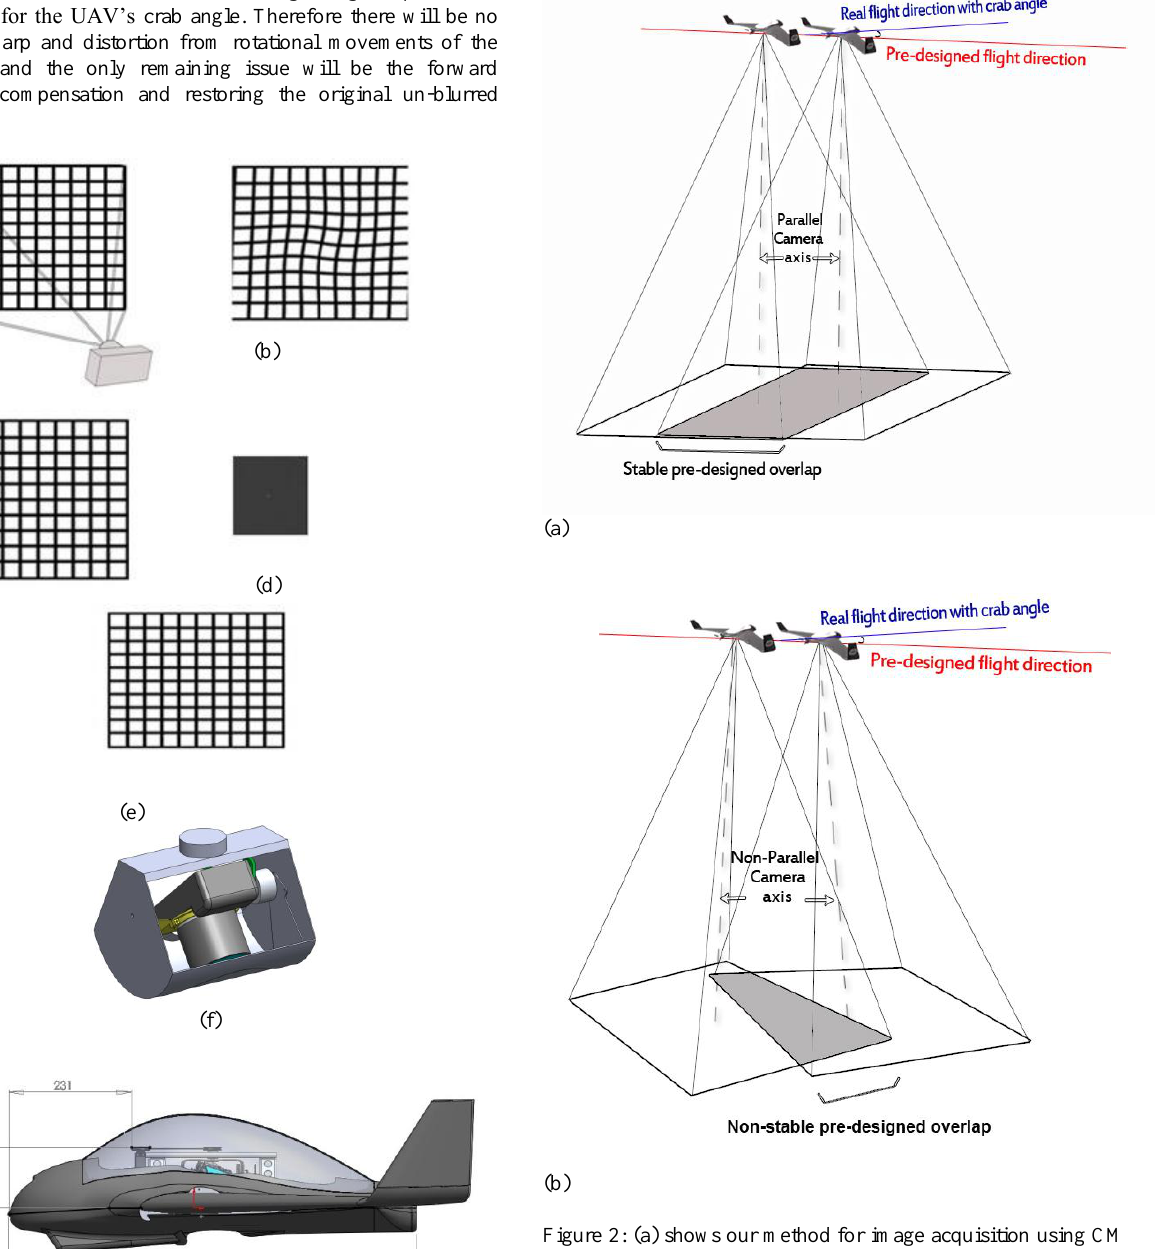
Figure 2: (a) shows our method for image acquisition using CM and parallel camera axis in all flight conditions with compensation for crab angle. Photos are taken in pre-designed flight direction with stable overlap, models are parallax free and tie points matching will be accelerated in aerial triangulation. Stereo models can be imported in stereo plotters for 3D feature extractions (b) shows the effect of non-parallel camera axis, captured images are not aligned with pre-designed flight direction and requires large overlaps to full-fill the minimum stereo overlap requirement, tie points matching requires more processing